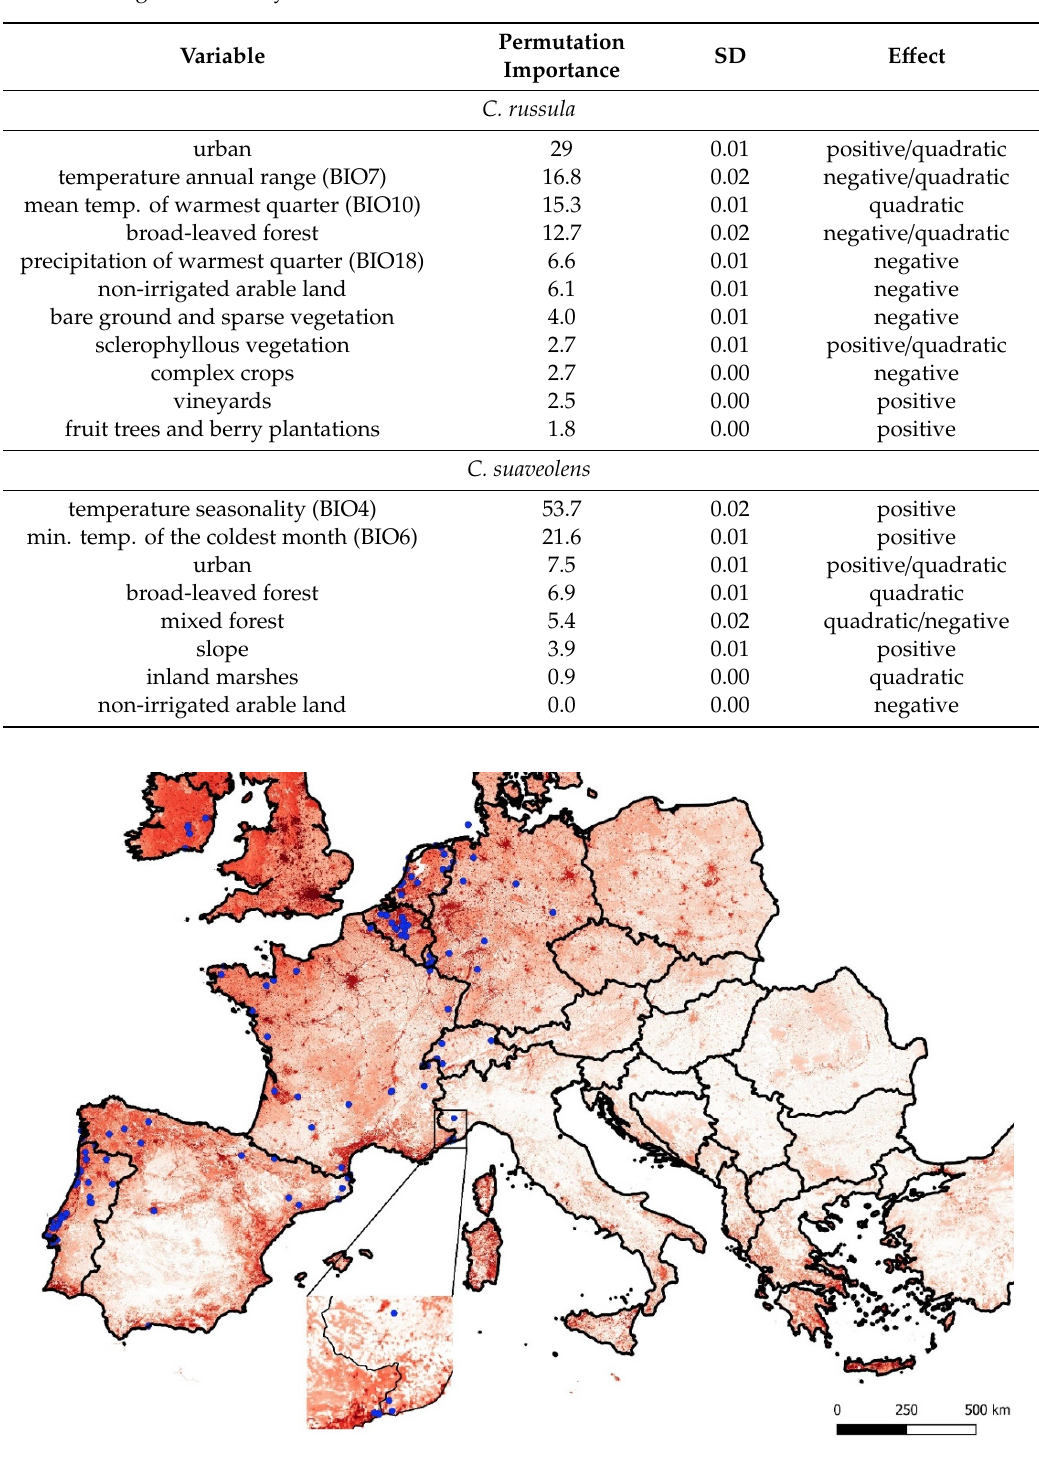
Table 3. Variables included in the distribution models, relative permutation importance (and SD calculated over 10 permutations) and description of the variable e ff ects. The quadratic e ff ect always refers to higher suitability at intermediate values.